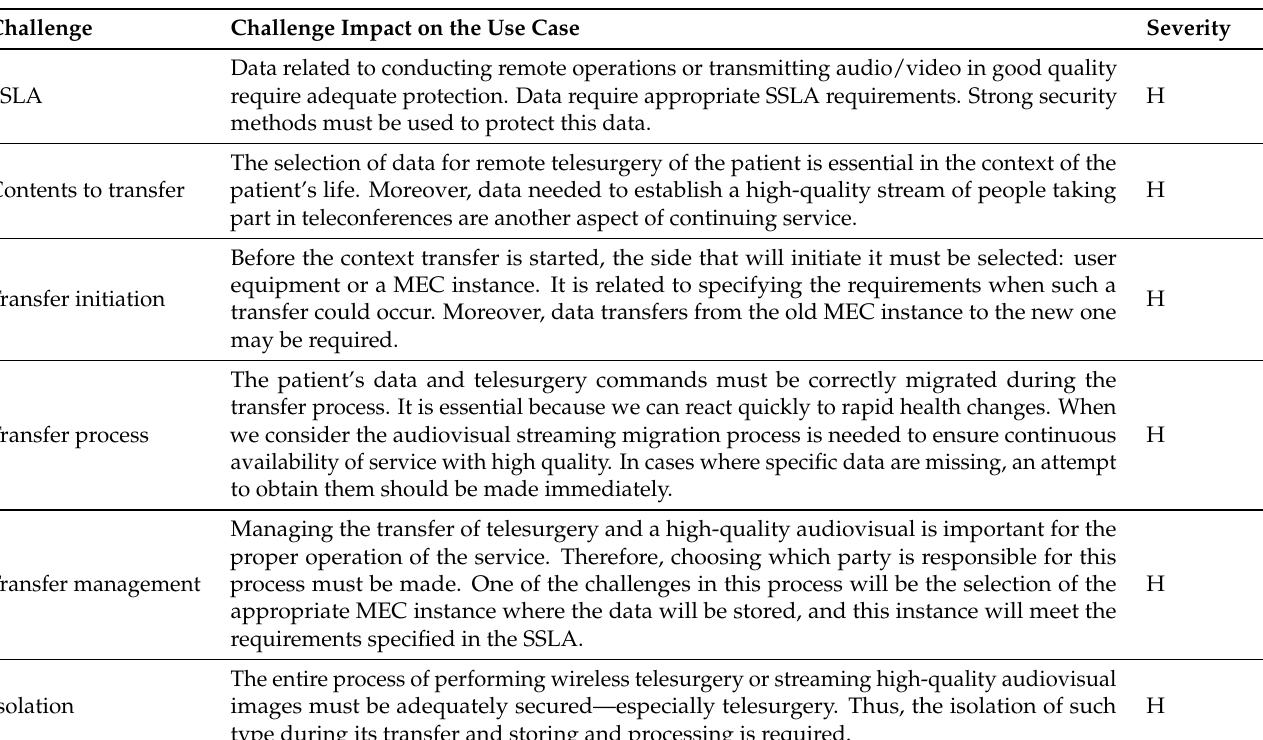
Table 9. Challenges in the wireless telesurgery use